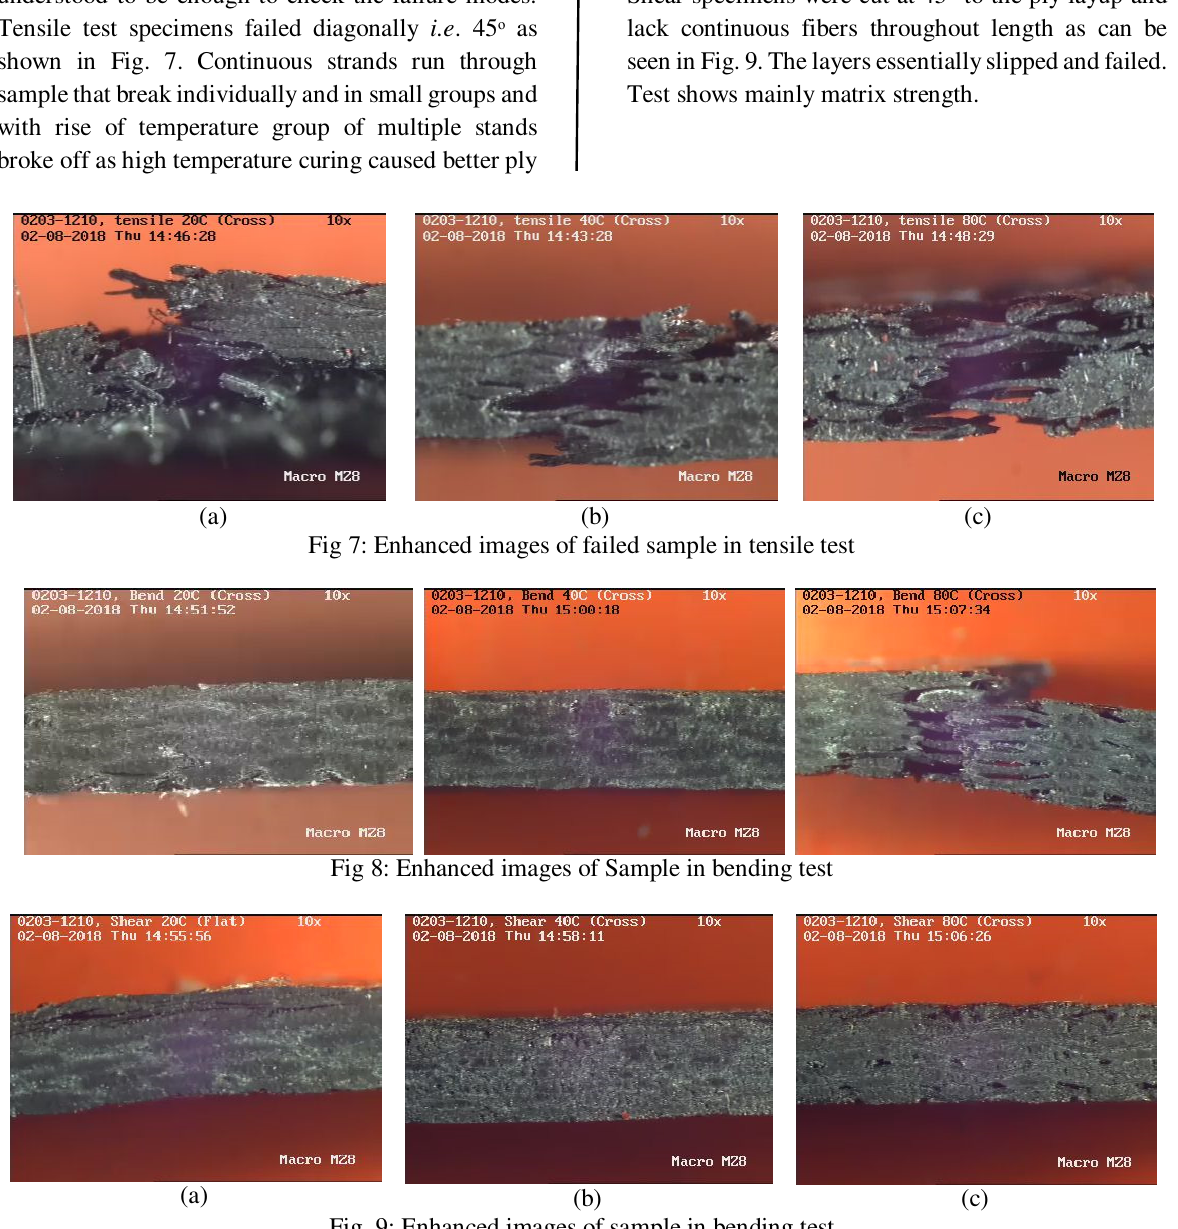
Fig. 9: Enhanced images of sample in bending test